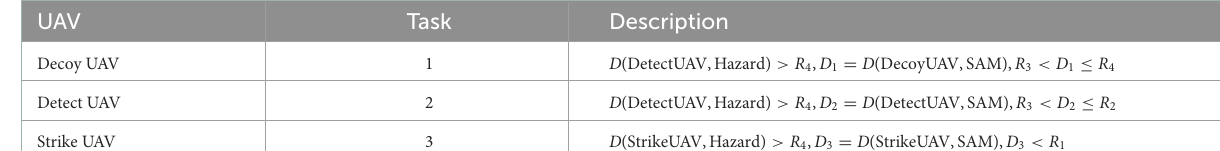
TABLE 1 Task allocation. UAV Task